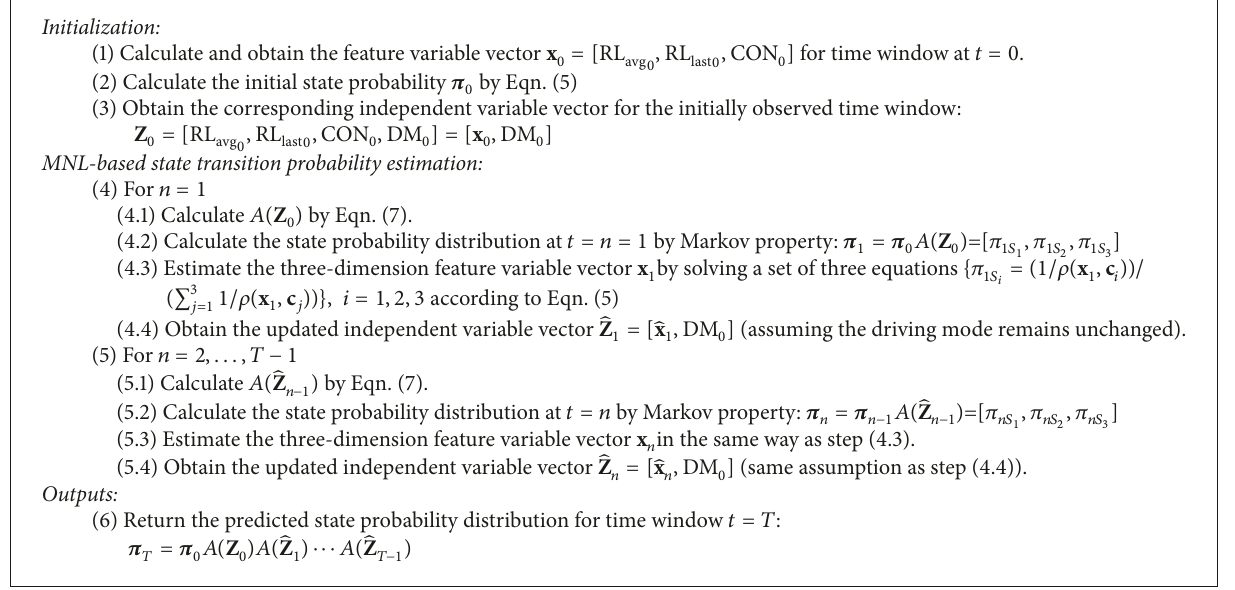
Algorithm 1: The description of MNL-based Markov chain risk state prediction